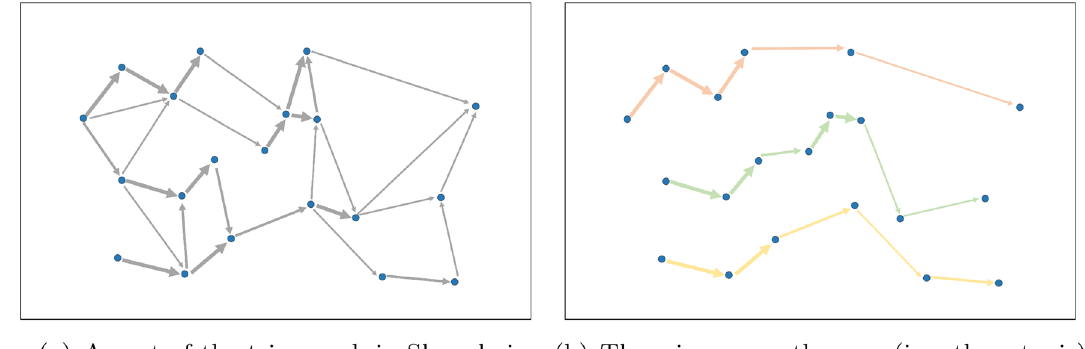
Fig. 22 An example of the minimum taxi fleet analysis